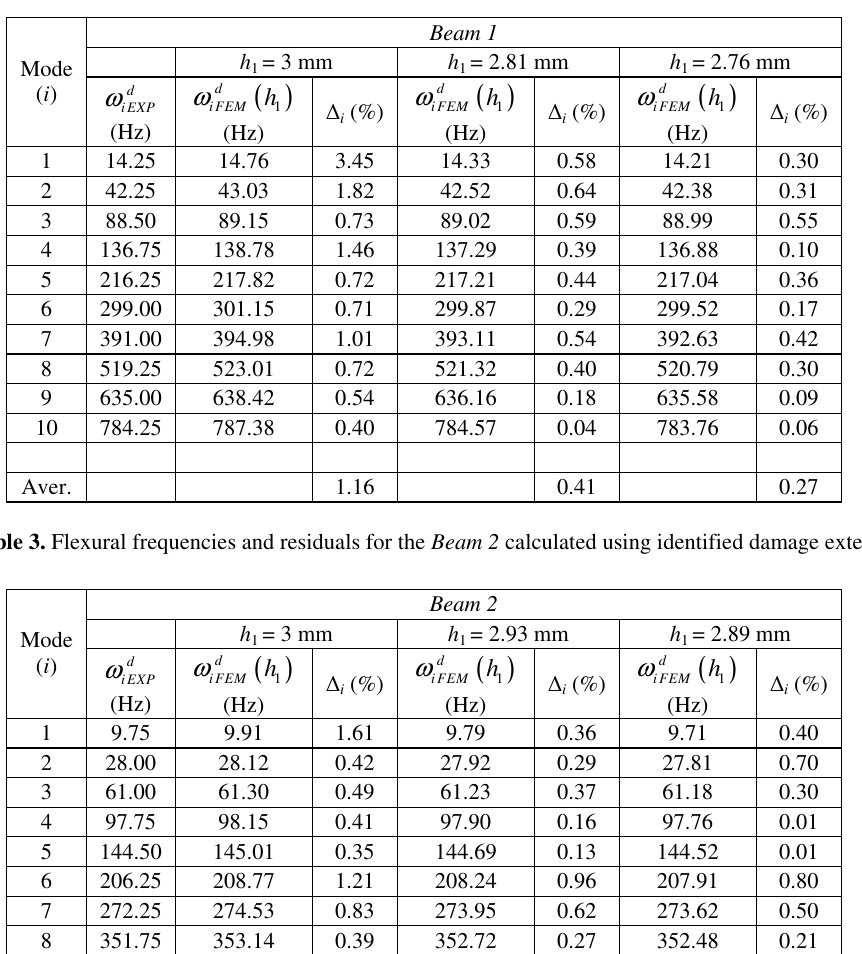
Table 2. Flexural frequencies and residuals for the Beam 1 calculated using identified damage extent